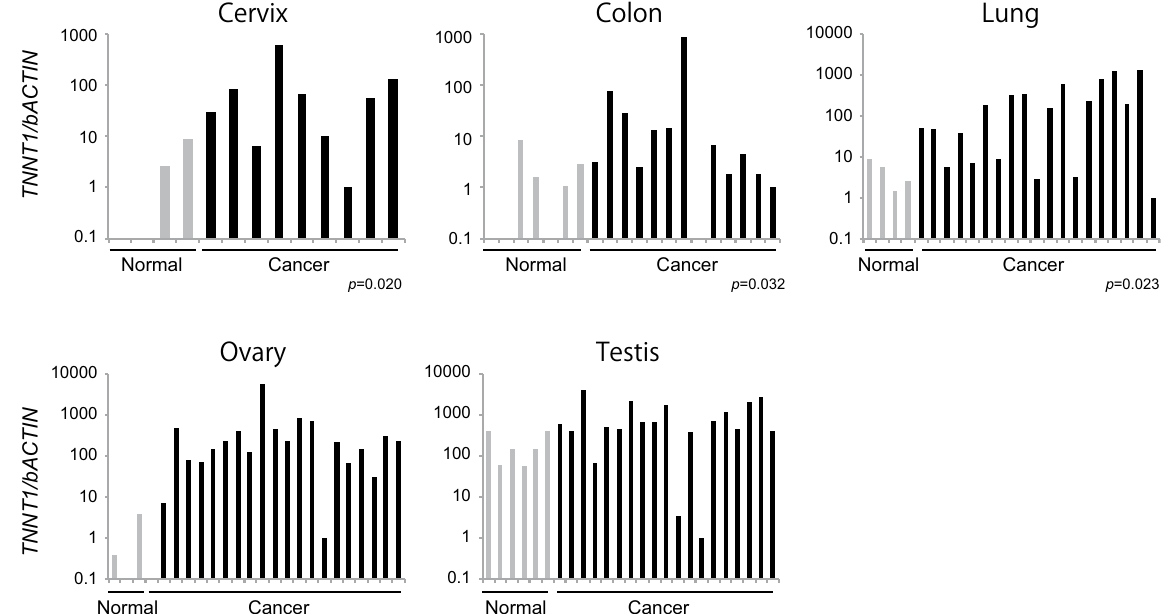
Figure 5. Versatility of TNNT1 as a marker of immortalized cells. Expression of TNNT1 in human cancer tissues and normal tissues was quantified using the TissueScan Cancer Survey Panel. Data were obtained using the comparative CT method, with values normalized to β -actin levels. Bar graph represents fold expression of TNNT1 relative to the lowest detected sample in cancer tissue samples (black; cancer tissue, gray; normal tissue). Blank: not detected. Statistical analysis was performed using the Mann–Whitney U